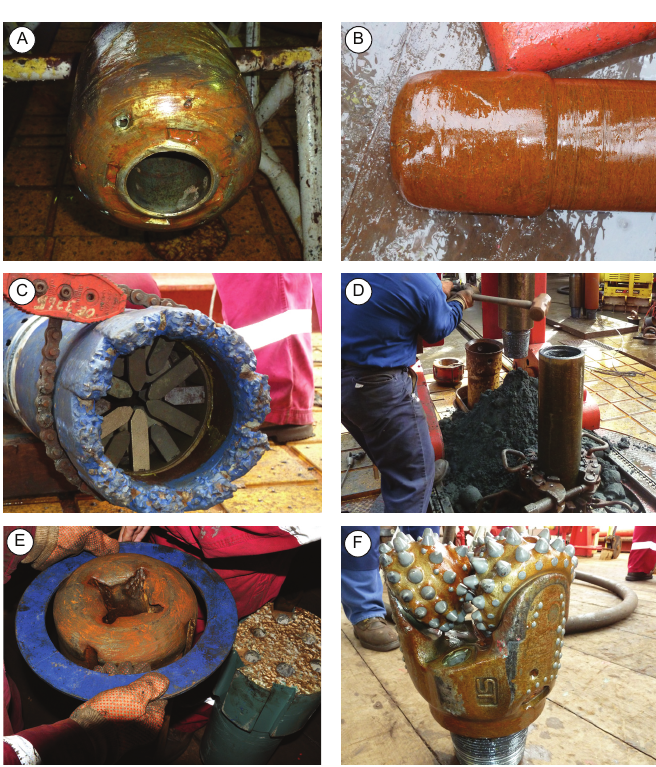
Figure 6. Photographs of some drilling, fishing, and milling tools illustrating the multiple operations achieved during IODP Expedition 335. [A] & [B] Remains of the Ulterra C9 RCB coring bit used during Run 9. The bit was probably used for ~10 h after it disintegrated, which resulted in this spectacularly abraded and sculptured bit (“Stumpy”), something never seen before by the drillers. [C] Bottom of the Bowen Reverse Circulation Junk Basket (RCJB), showing its hard-facing structure and the junk catcher spring fingers inside. This tool recovered a series of large-scale cobbles (up to 5 kg) of granoblastic basalt. [D] A series of RCJB runs returned a bottom hole assembly packed by fine-grained cuttings. This contributed efficiently to cleaning Hole 1256D. [E] Heavily worn and under-gauge 9-inch flat-bottomed milling tool. This tool worked at the bottom of the hole for 12 h; its final state indicates the very abrasive nature of metal debris and/or rocks at the bottom of the hole and an under-gauge lowermost portion (tens of centimeters) of the hole. Note for comparison the hard-facing structure of the next milling tool on the right side of the picture. [F] 9-inch Smith FH3VPS tricone bit used for Run 16. This armored bit was efficient to ream and clean the under-gauge bottom of the